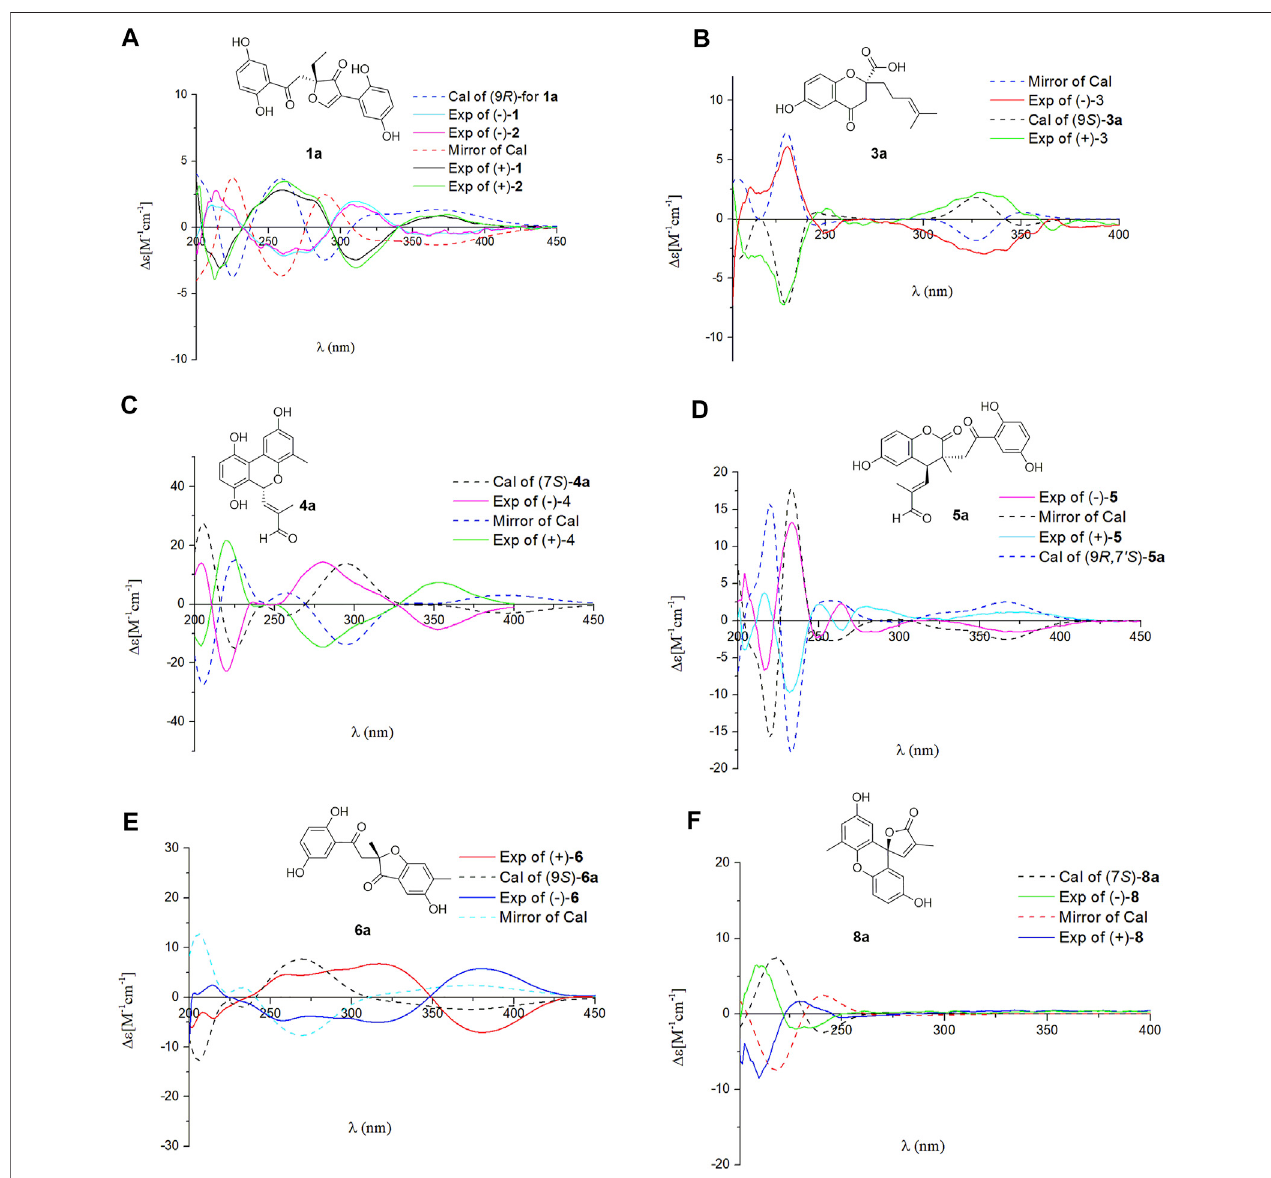
FIGURE 4 | Comparison of the calculated ECD spectra with the experimental CD spectra in MeOH. (A) The calculated ECD spectrum of (10 S )- 1a at APFD/6- 311+G(2d,p)level, σ =0.30 eV;shift= – 12 nm. (B) ThecalculatedECDspectrum of(9 S )- 3a atB3LYP/6-31G(d,p)level, σ =0.20 eV;shift=+20 nm. (C) Thecalculated ECD spectrum of (7 S )- 4a at B3LYP/6-31G (d,p) level, σ = 0.30 eV; shift = +0 nm. (D) The calculated ECD spectrum of (9 R ,7 ′ S )- 5a at B3LYP/6-31G (d,p) level, σ = 0.20 eV;shift=+0 nm. (E) ThecalculatedECDspectrumof(9 S )- 6a atAPFD/6-311+G(2d,p)level, σ =0.40 eV;shift= – 10 nm. (F) ThecalculatedECDspectrumof (7 S )- 8a at B3LYP/6-31G (d,p) level, σ = 0.30 eV; shift = – 30 nm.